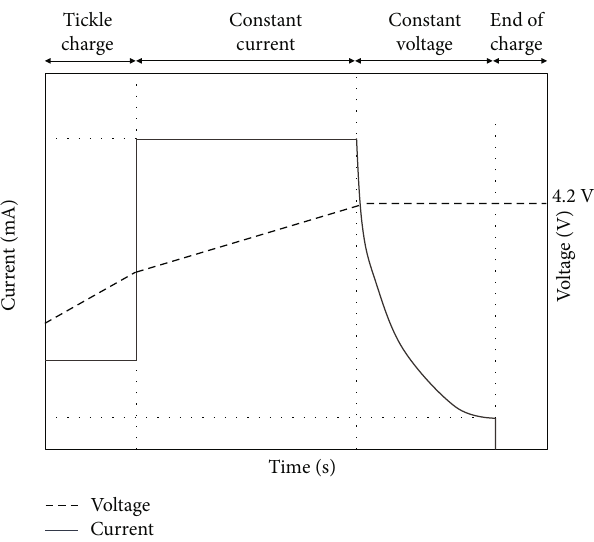
Figure 5: Constant-current and constant-voltage charging procedure for single-cell Li-ion batteries.